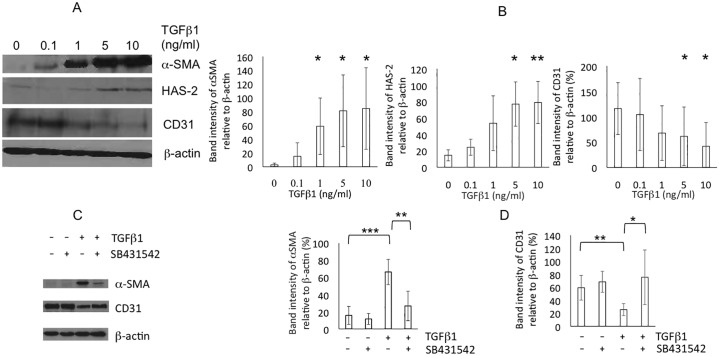
Normal valve endothelial cells (VEC).(A) Representative protein-immunoblot of normal VECs treated with 0, 0.1, 1, 5 and 10ng/ml TGFβ1 for 5 days (n = 4) illustrating expression of αSMA, HAS-2 and CD31. (B) Quantified expression of αSMA in (A) relative to β-actin. (C) Representative protein immunoblot illustrating effects of SB431542 on αSMA and CD31 expression. (D) Quantified expression of αSMA in (C) relative to β-actin. Statistical analysis was performed with Student’s t-test. *, **, *** P<0.05, 0.01, 0.001 respectively.